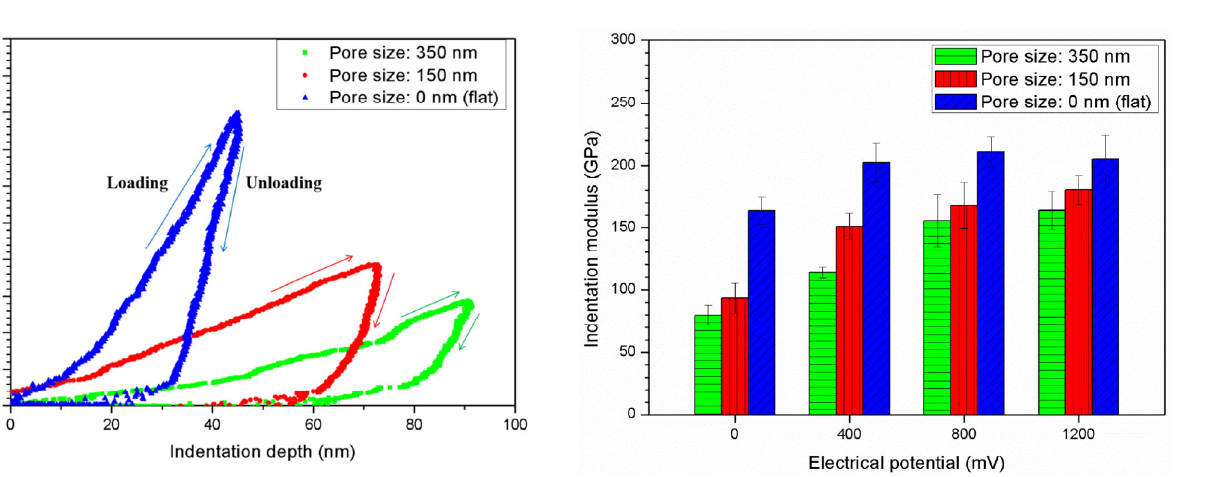
Fig. 4 Indentation modulus versus applied electric potential in metallic porous nanostructures with various pore sizes.